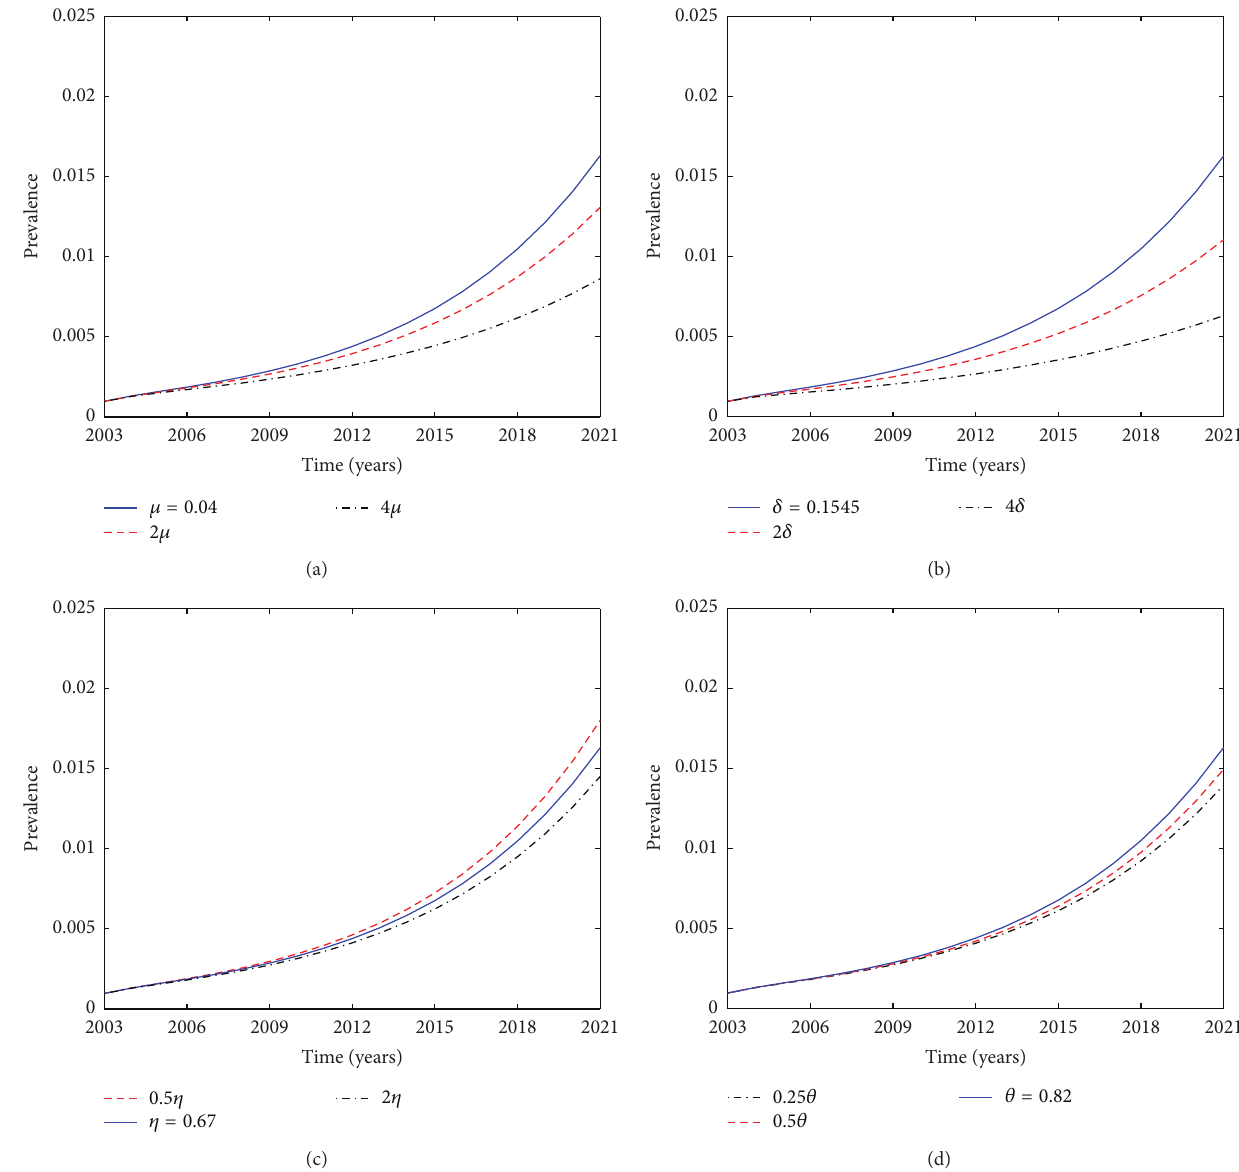
Figure 3: Plots of the prevalence against time at varying parameter values: (a) the treatment rate 𝜇 for patients at the acutely infected stage; (b) the treatment rate 𝛿 for patients at the chronic stage; (c) the treatment cure rate 𝜂 ; (d) the treatment failure rate 𝜃 . All the other parameters are as shown in Table